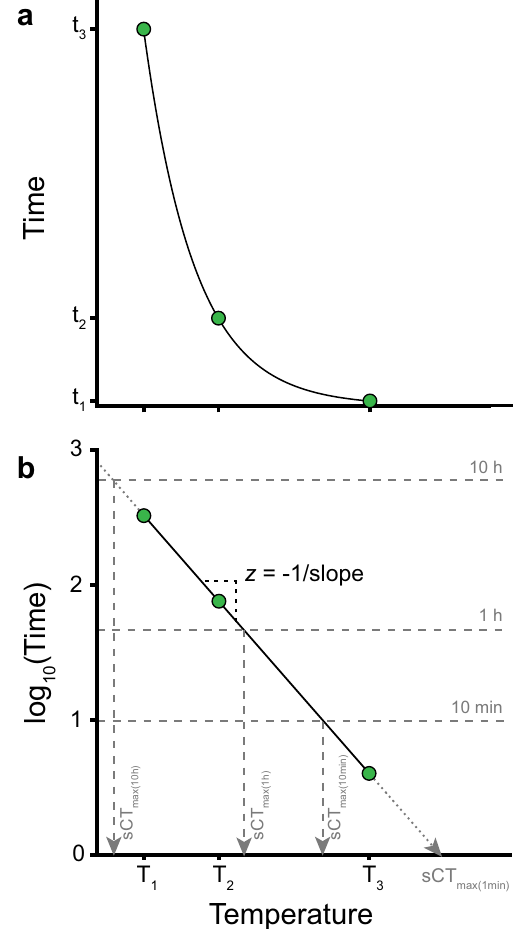
Figure 1. Exponential relation between temperature and t coma presented as a thermal death time (TDT) curve. ( A ) Time to coma (t coma ) decreases exponentially with temperature. ( B ) Observations from (A) presented as a TDT curve (however with coma rather than death time) where the linearity of log 10 -transformed t coma versus temperature indicates the exponential relation (full line). The negative inverse slope of the TDT curve is used as the thermal sensitivity parameter z ( z = the change in temperature required to change t coma by an order of magnitude). Intersections between the TDT curve and horizontal lines show the temperature (sCT max ) at which coma is expected to occur after a fixed time (e.g. 1 h, sCT max (1 h) ). Extrapolations in either end of the TDT curve (dotted lines) are tempting but should be met with caution as the relationship is only linear in a certain time– temperature interval (see “Discussion”